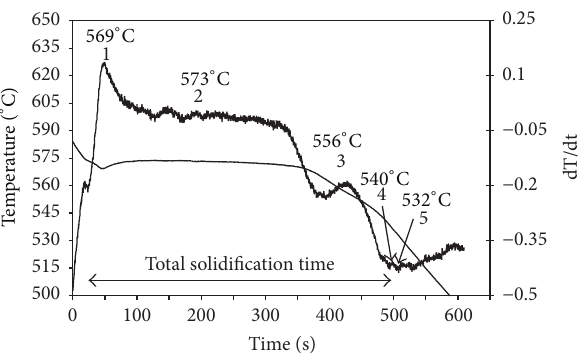
Figure 1: Temperature-time solidification curve and its first derivative of the base alloy: ( 1 ) precipitation of 𝛼 -Al network, ( 2 ) precipitation of Al-Si, ( 3 ) precipitation of Fe intermetallics, ( 4 ) precipitation of Al 2 Cu, and ( 5 ) end of